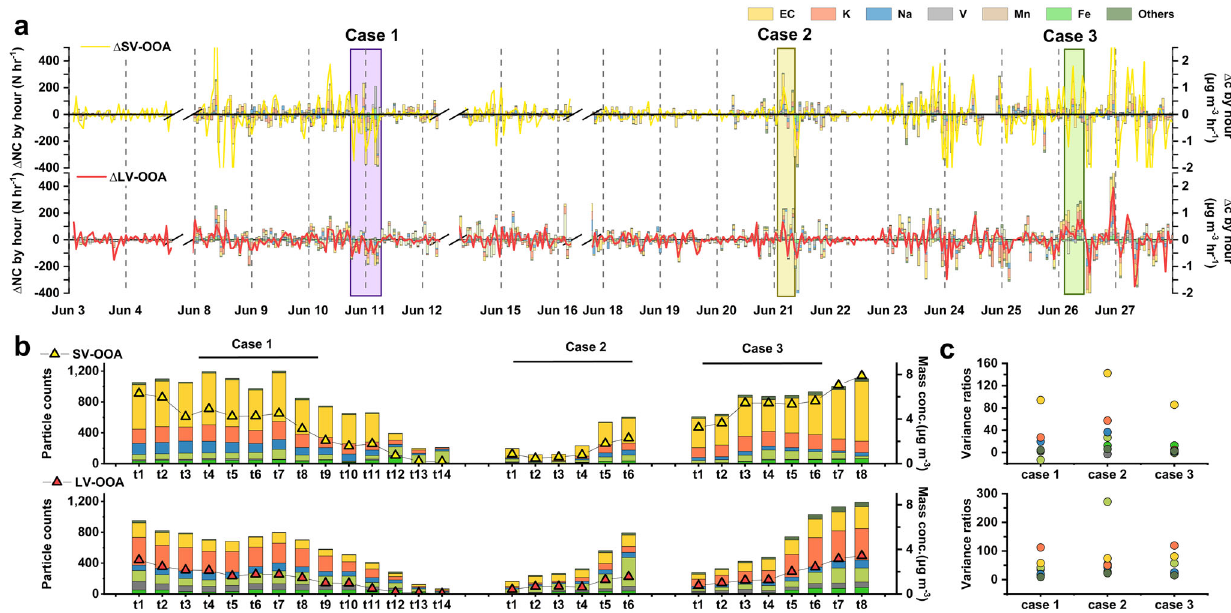
Fig. 5 Evolution patterns of OOA oxidation degree. a Variation rates of the OOA mass concentration with the ACSM instrument and OOC particle number concentration (NC) via SPAMS; b OOA mass concentration and OOC particle counts in the three typical cases; c the variation ratios of each subgroup in the three typical